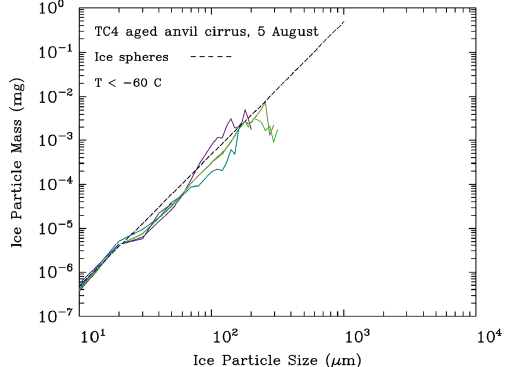
Figure 5. Example of how ice particle area- and mass-dimension power law expressions were Fig. 5. Example of how ice particle area- and mass-dimension derived from the 2D-S data. Colored curves show the 2D-S data while the dashed line is for ice power law expressions were derived from the 2D-S data. Colored spheres at bulk density (representing an upper limit). See text for details. curves show the 2D-S data while the dashed line is for ice spheres at bulk density (representing an upper limit). See text for